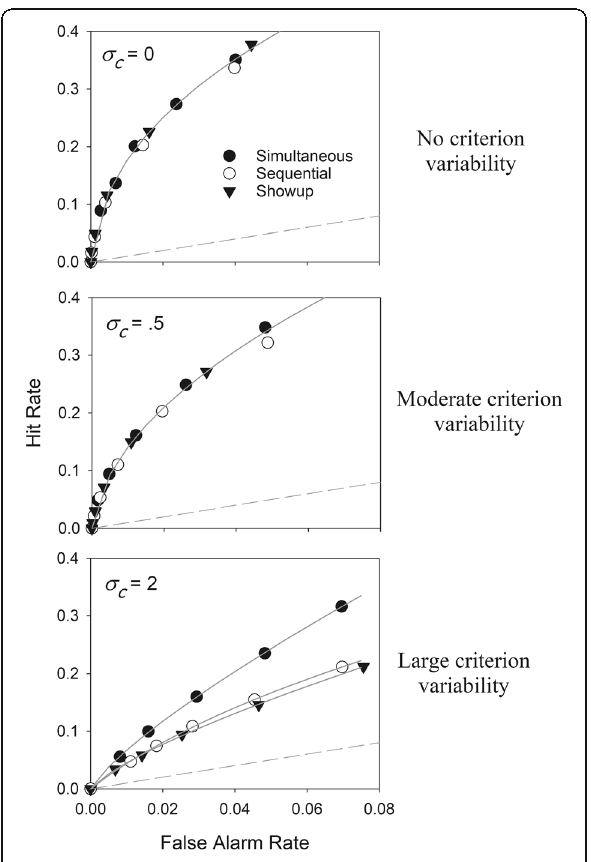
Fig. 7 Simulated receiver operating characteristic (ROC) data generated by a simultaneous lineup using the MAX decision rule, a sequential lineup using the “ first-above-criterion ” decision rule, and a showup. A showup is an old/new recognition memory task in which a single face is presented for an old/new decision. For all three procedures, d' was set to 1.4, the overall decision criterion was set to 1.7, and 100,000 simulated trials were run. The top panel shows the simulated results with criterion variability set to 0. The middle panel shows the simulated results with criterion variability set to 0.5. The bottom panel shows the simulated results with criterion variability set to 2.0 (extreme criterion variability). The confidence criteria were programmed to shift in lock step to prevent violations of monotonic order (lowest = 1 to highest = 5). The dashed line represents the line of chance